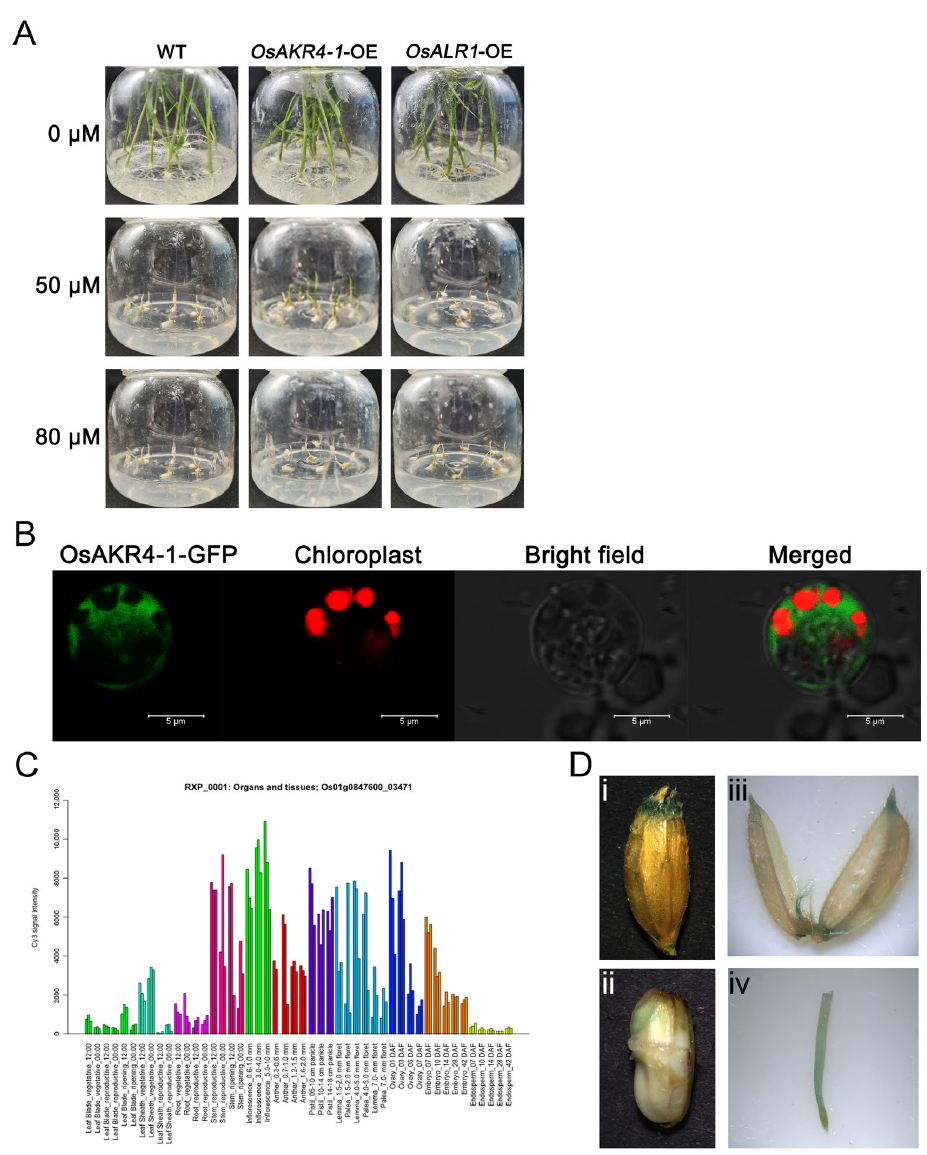
Figure 6. OsAKR4-1 overexpressed in rice-seedling growth in glyphosate and its cellular and tissue localization. ( A ) Growth of germinated rice seedlings mediated by OsAKR4-1 and OsALR1 with 50 and 80 μM glyphosate. ( B ) Subcellular localization of OsAKR4-1 in rice protoplast; OsAKR4-1 fused with GFP was transiently co-expressed with chloroplast marker with mCherry in rice-sheath proto- plasts. Scale bar = 5 μm. ( C ) Gene expression profiles of OsAKR4-1 in various organs throughout the entire growth period, as quoted from RiceXPro (https://ricexpro.dna.affrc.go.jp, accessed on 18 July 2022). ( D ) Tissue-specific localization of pOsAKR4-1 ::GUS in transgenic rice, such as in the glume ( i ), seed ( ii ), lemma ( iii ), and root ( iv ).